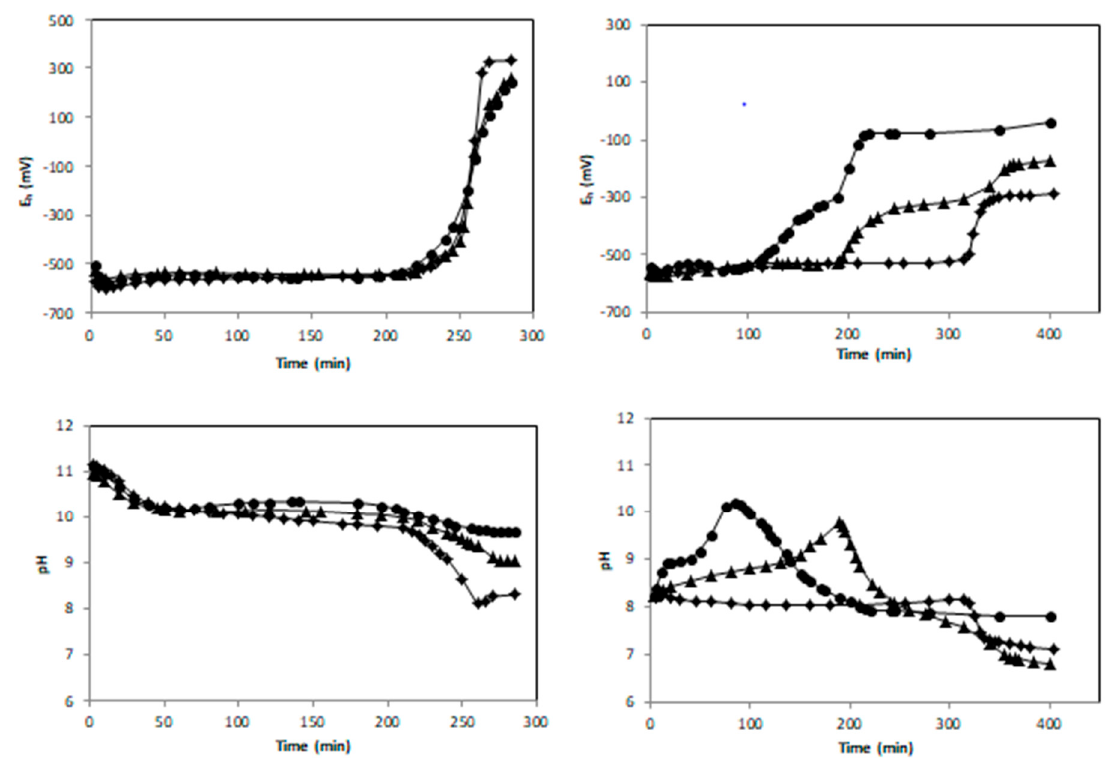
Figure 1. E h and pH vs time for R = 0.5 ( left panel , birnessite added at t = 50 min) and R = 0.6 ( right panel , birnessite added at t = 3 min): diamond, triangle and circle correspond to [Bir] = 0, 2 and 5 g·L − 1 , respectively.